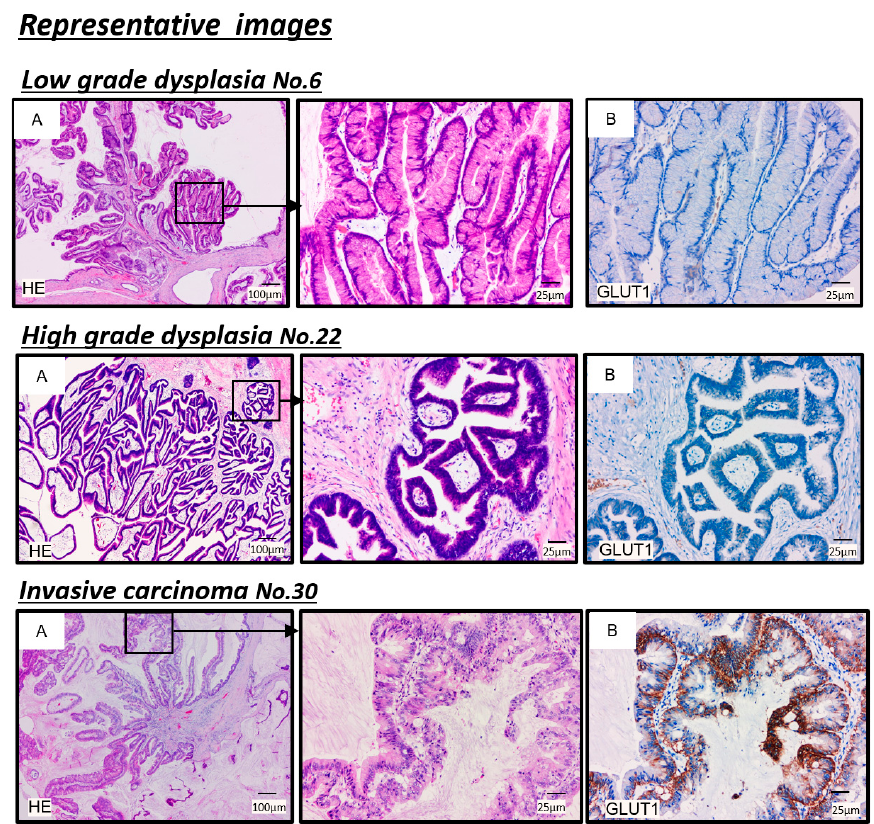
Figure 4. Representative hematoxylin and eosin (H&E)-stained images and immunohistochemical images for GLUT1 in IPMNs with low-grade dysplasia, high-grade dysplasia, and invasive carci- noma are shown. ( A ) H&E-stained sections of clinical specimens of IPMN. Areas in the boxed re- gions on the left are shown magnified on the right. ( B ) Immunohistochemical staining for GLUT-1. GLUT-1: glucose transporter 1; IPMN: intraductal papillary mucinous neoplasm. glucose transporter 1; IPMN: intraductal papillary mucinous